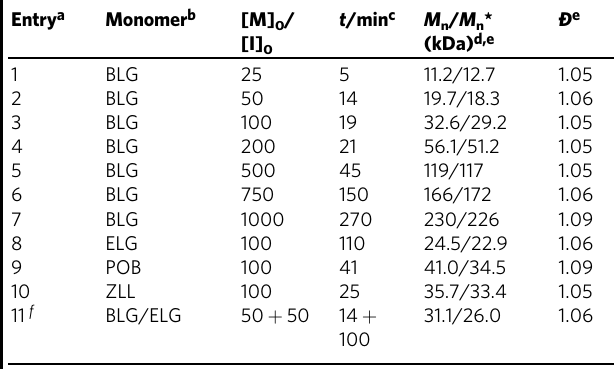
Table 2 Accelerated polymerization of NCA initiated by helical PBLG macroinitiator catalyzed by